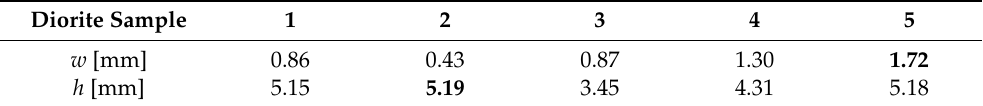
Table 4. The distance between the point of observed crack initiation and disc centre and optimal gauge lengths for the diorite. The critical values used to define the RSR are marked in bold font. Diorite Sample 1 2 3